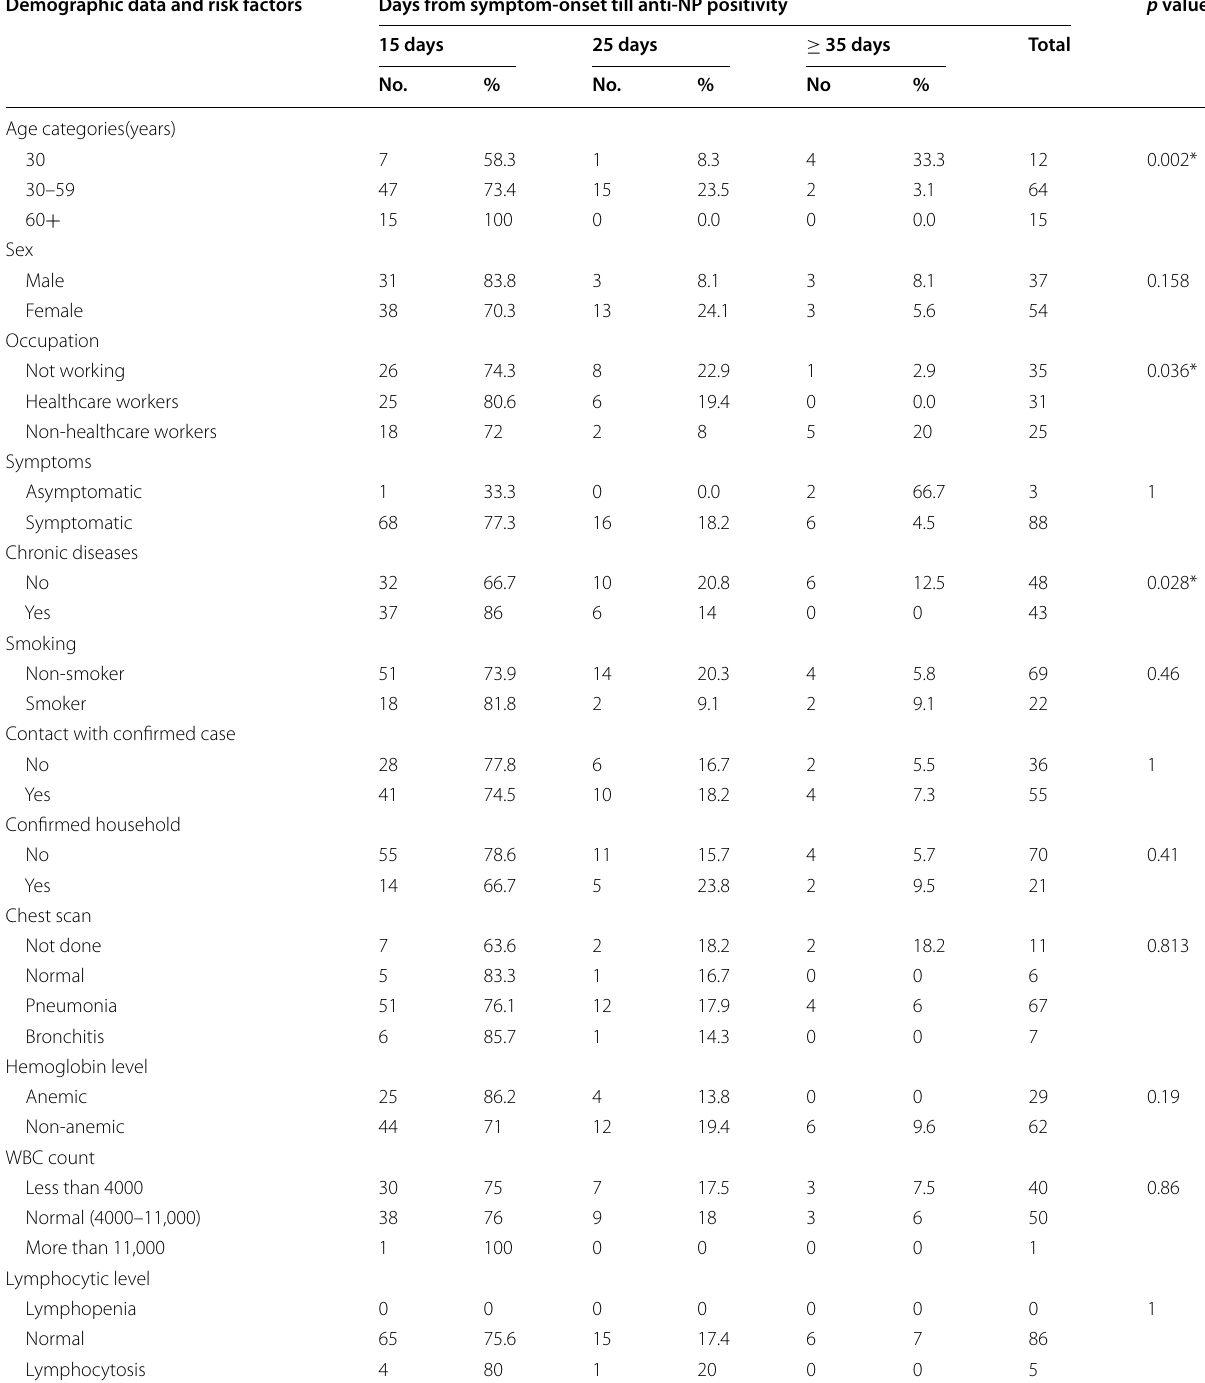
Table 3 Demographic data and risk factors of 91 COVID-19 home-isolated patients according to the onset of positivity of SARS-CoV-2